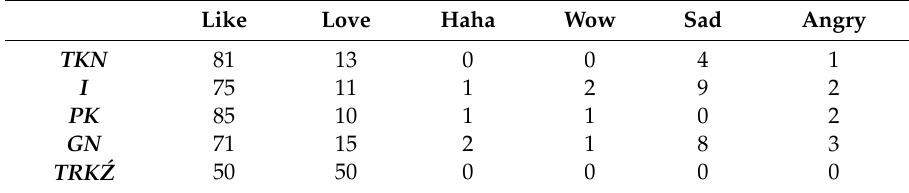
Table 15. Types of reactions on FB profiles of the Catholic